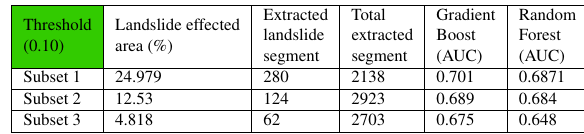
Table 5: Result for subset(Test area)